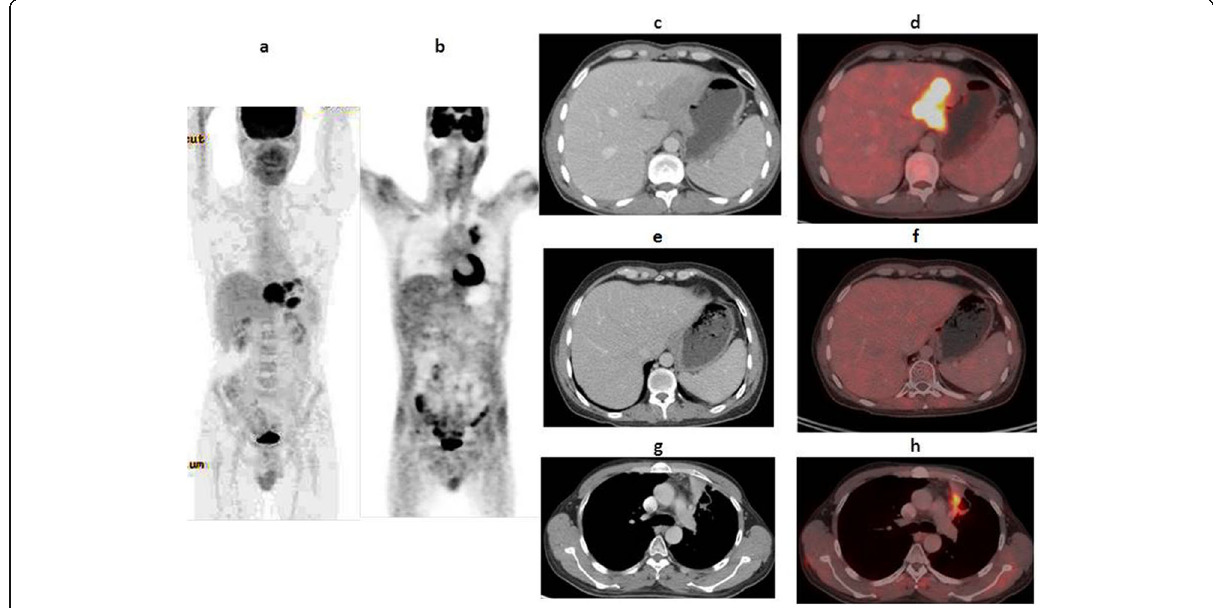
Fig. 3 A 35-year-old male patient, newly diagnosed case of gastric lymphoma. Initial PET/CT study including whole body PET MIP ( a ), axial CECT ( c ), and corresponding fused PET/CT ( d ) images revealed irregular hypermetabolic gastric soft mass infiltrating the related left hepatic lobe and achieving 22.8 SUL peak . Follow-up PET/CT study revealed complete resolution of the mass in whole body PET MIP ( b ) as well as axial CECT ( e ) and corresponding fused PET/CT ( f ) images denoting CR and CMR according to RECIST 1.1 and PERCIST 1.0, respectively. However, the whole body image ( b ) showed another newly developed metabolically active lesion at upper lobe of left lung that was a pneumonic consolidative patch in axial images ( g ) and ( h